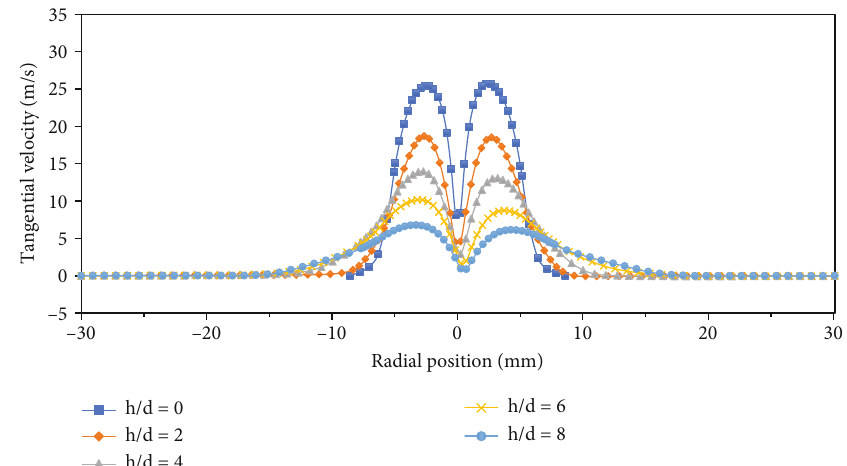
Figure 9: Development law of tangential velocity of water.